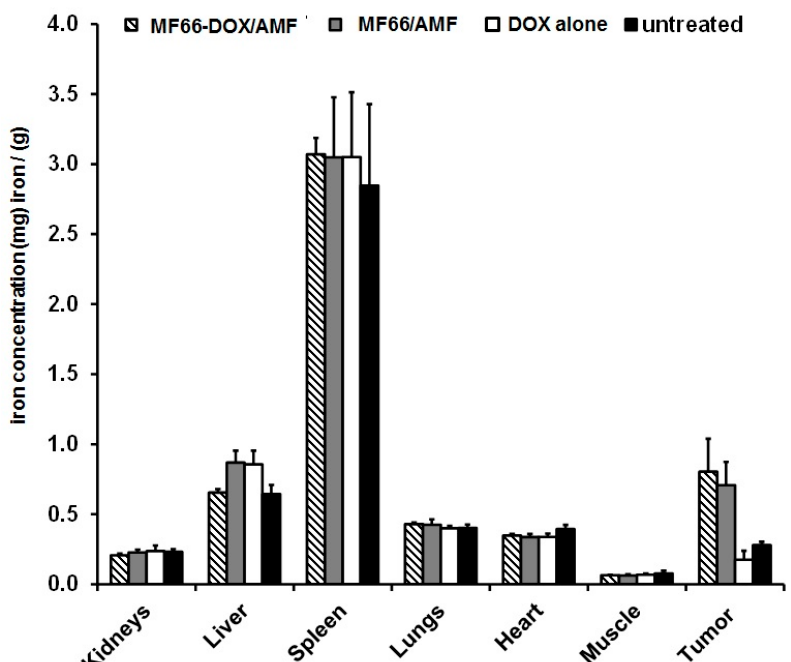
Figure 4. The intratumorally injected MNPs remain within the tumor after hyperthermia treatment. Iron concentration in selected organs 28 days after magnetic hyperthermia treatment. Mean and standard deviation of n ≥ 4 animals per group.